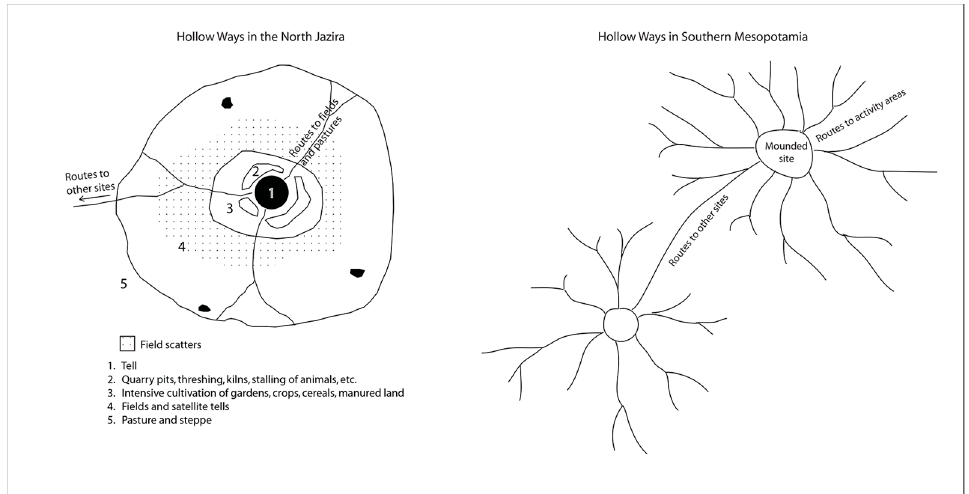
Figure 11. In the North Jazira (left), hollow ways fall into one of three classes: routes from settlement to surrounding fields, routes that continue beyond the fields to pasture, and long distance routes that connect sites [12]. In Southern Mesopotamia (right), hollow ways fall into one of two categories: routes to activity areas and routes that connect sites.